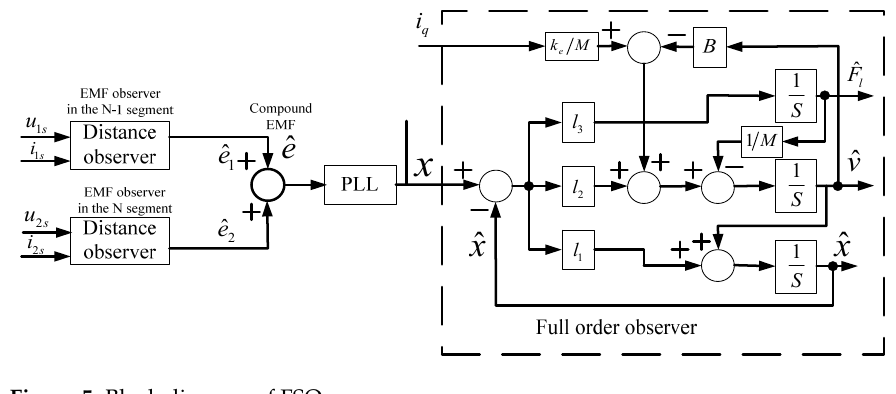
Figure 5. Block diagram of FSO.